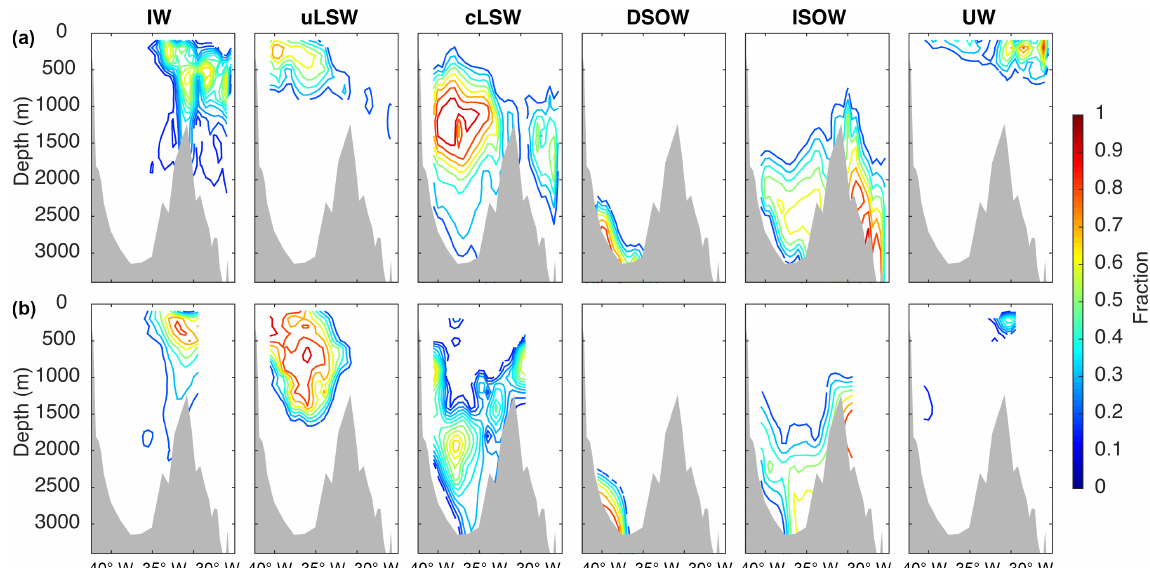
Figure B1. Vertical cross section of fraction of water masses (IW, cLSW, uLSW, DSOW, ISOW and UW) in (a) 1991 and (b) 2015. Ratios below 0.1 are set to zero for